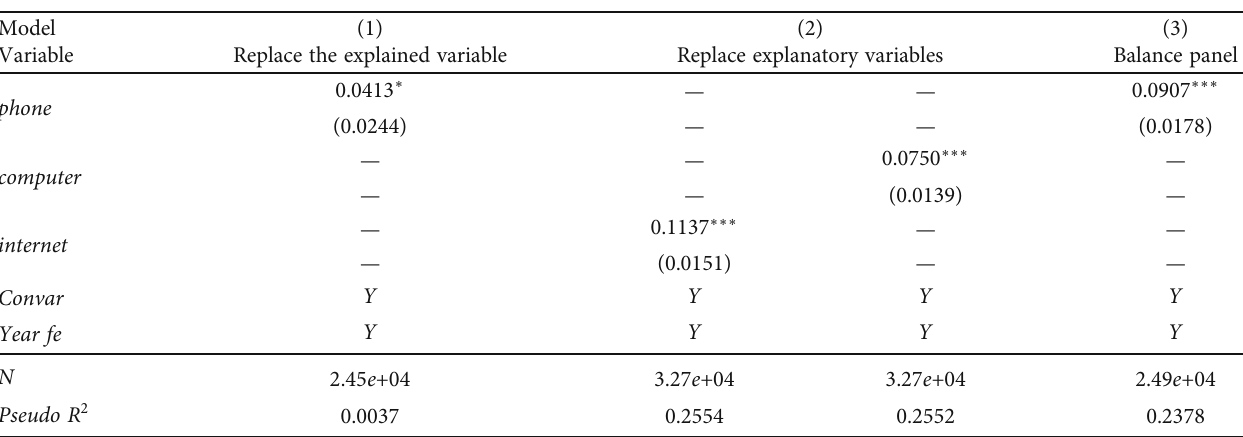
Figure 2: Probability distribution density function plot of propensity score value. Table 7: Robustness